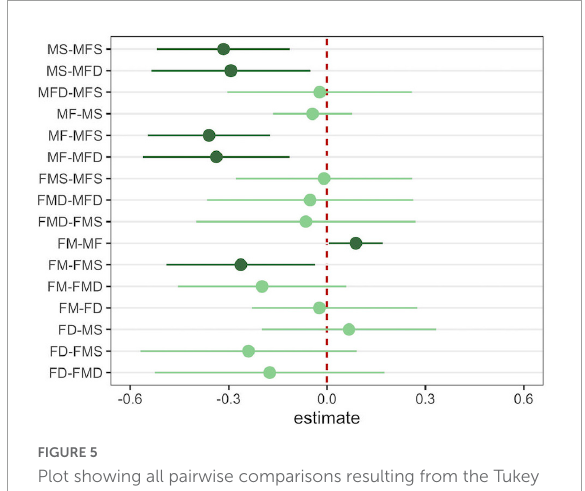
FIGURE5 Plot showing all pairwise comparisons resulting from the Tukey test. Dark green points and lines represent the estimate and 95% confidence interval of significant comparisons. Light green points and lines represent the estimate and 95% confidence interval of non-significant comparisons. M, mothers; F, fathers; D, daughters; S,